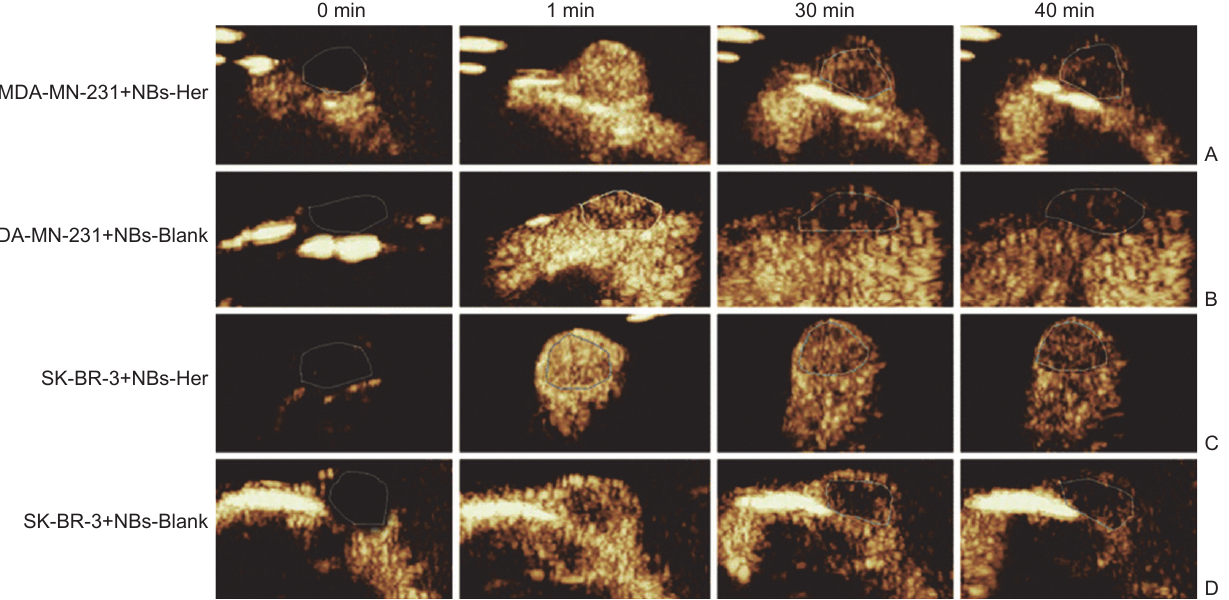
Figure 3 In vivo tumor targeting. Images were taken at the indicated time points (0, 1, 30, and 40 min) after nanobubbles were injected into the transplanted SK-BR-3 tumors injected with Herceptin-conjugated nanobubbles (NBs-Her; A) or unconjugated nanobubbles (NBs-Blank; B) and in the transplanted MDA-MB-231 tumors injected with NBs-Her (C) or NBs-Blank (D) (Reprinted with permission from reference